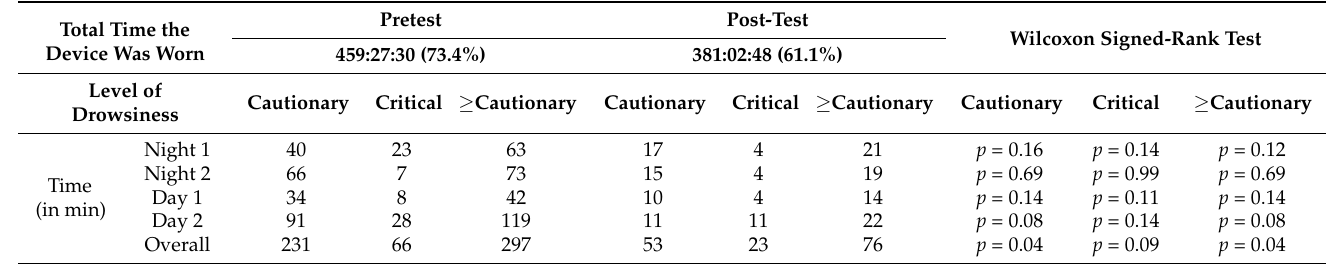
Table 3. Drowsiness monitoring pre- and post-test ( n =